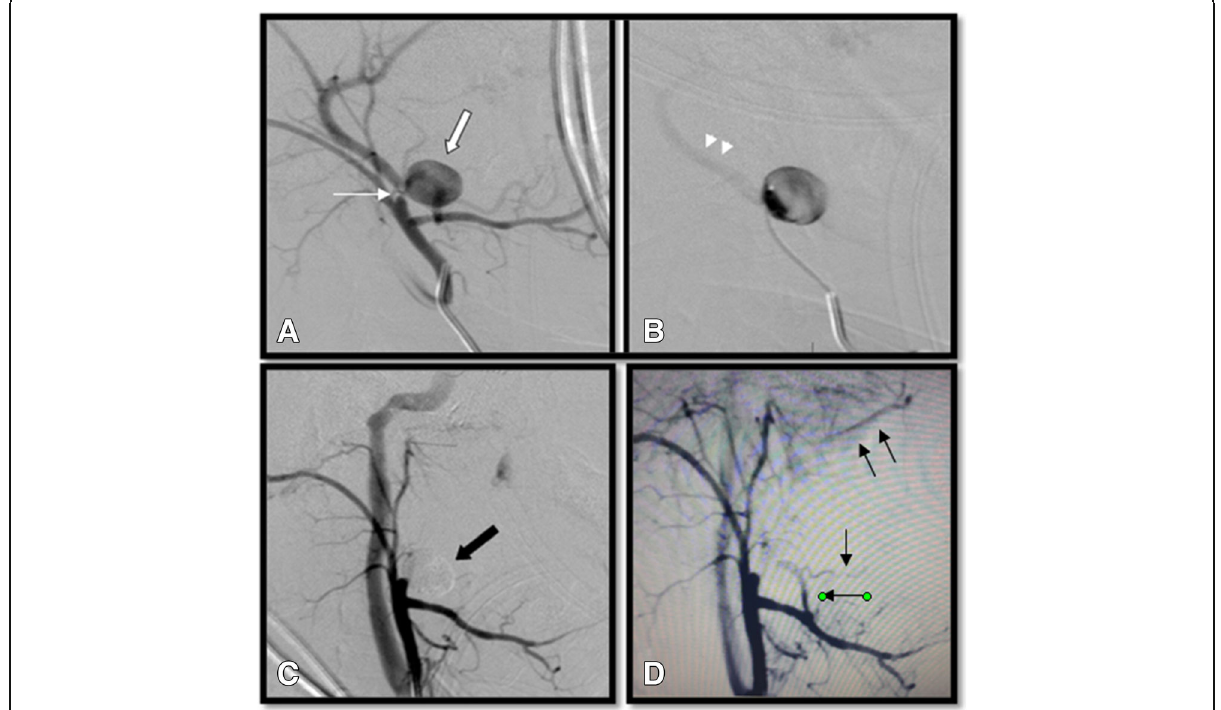
Fig. 3 a ECA angiography shows a pseudoaneurysm (thick white arrow) arising at the ostium of the facial artery (thin white arrow). b S uperselective angiography with the tip of microcatheter within the pseudoaneurysm with faint contrast reflux opacifying the main ECA (arrowheads). c , d Post embolization ECA angiography, showing occlusion of the pseudoaneurysm (black arrow) with proximal reflux of the glue and occlusion of adjacent part of the ECA. Few collaterals are refilling the internal maxillary and facial arteries in a retrograde manner (thin